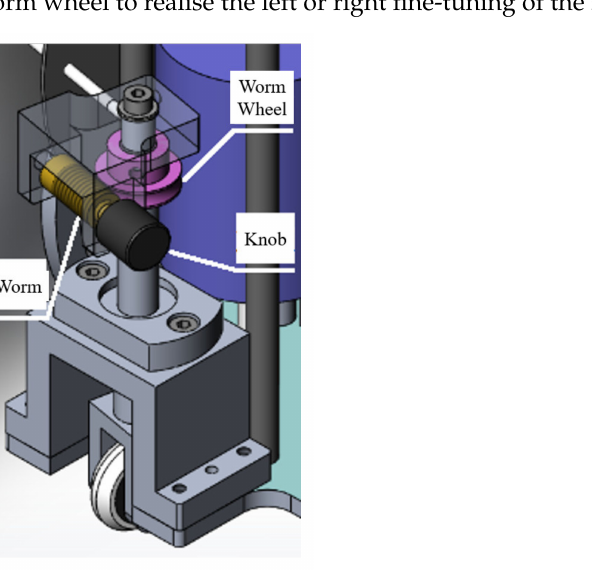
Figure 7. Worm gear fine adjustment mechanism.